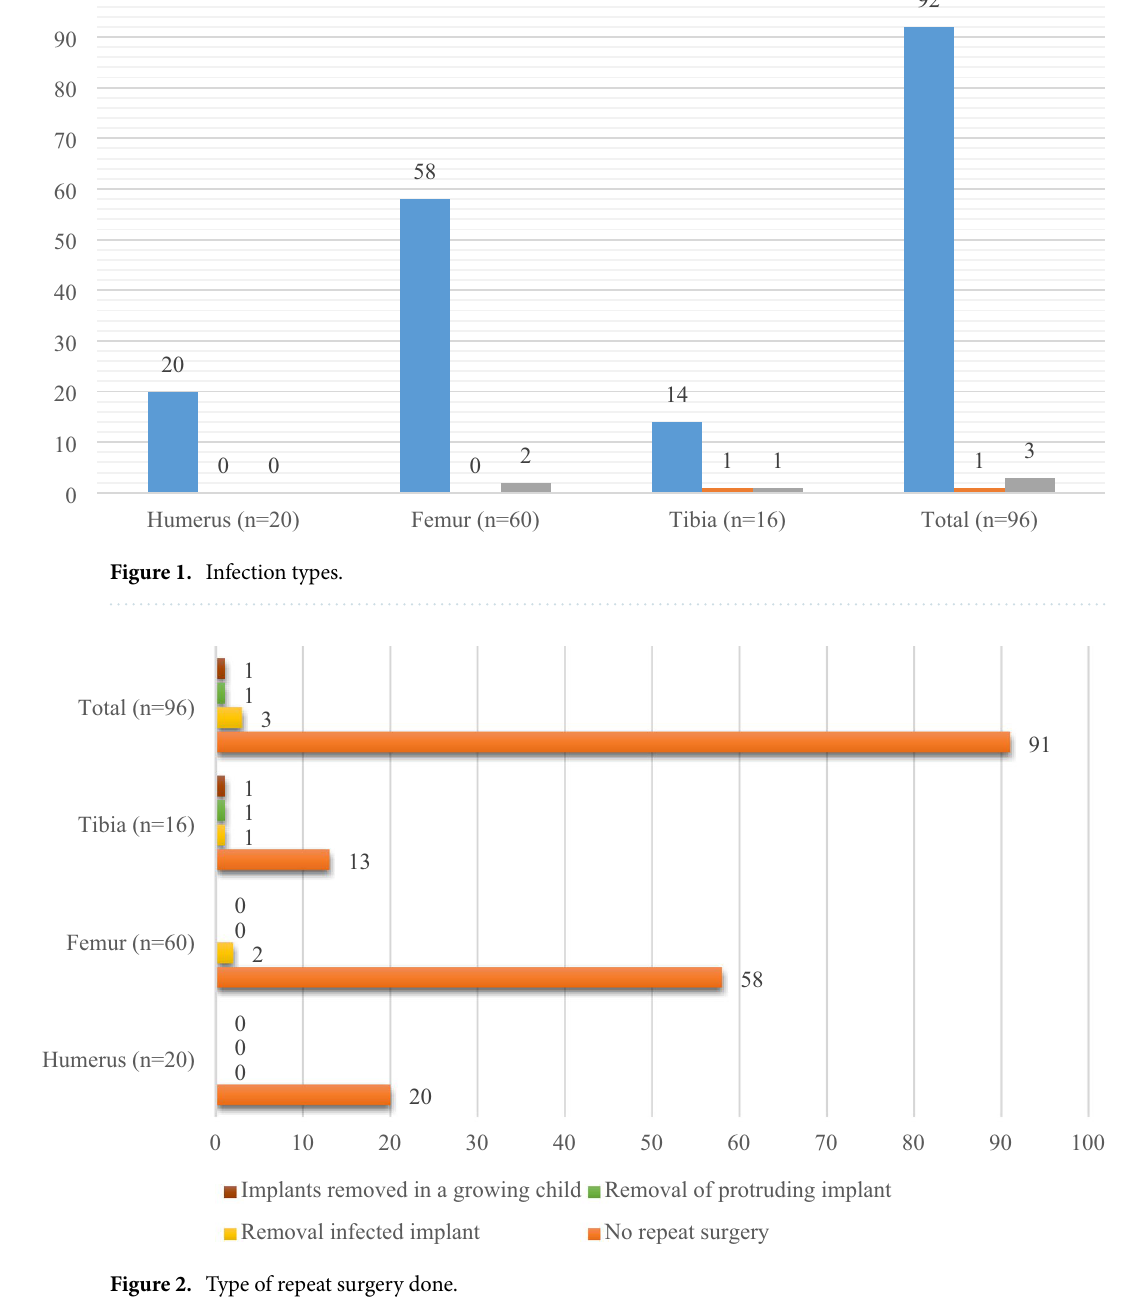
Figure 2. Type of repeat surgery